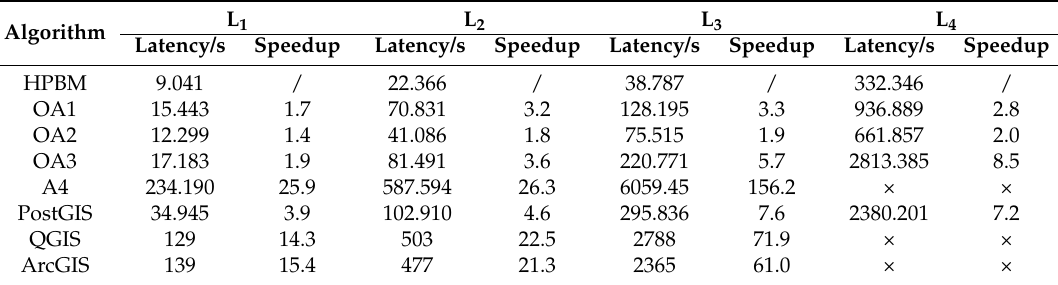
Table 7. Stand-alone experiment. GIS: geographic information systems; HPBM: Hilbert curve partition buffer